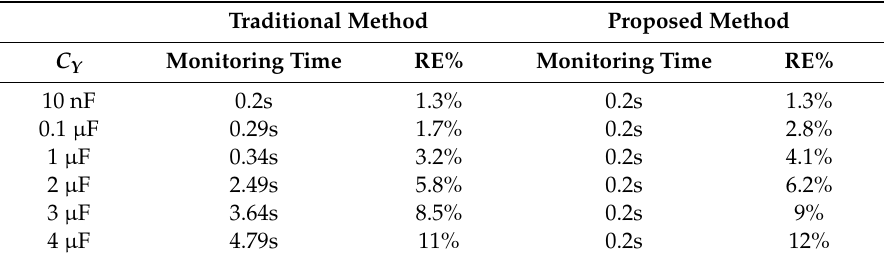
Table 4. Comparison of monitoring data in v dc = 400 V, R f 1 = 1000 k Ω , R f 2 = 300 k Ω .